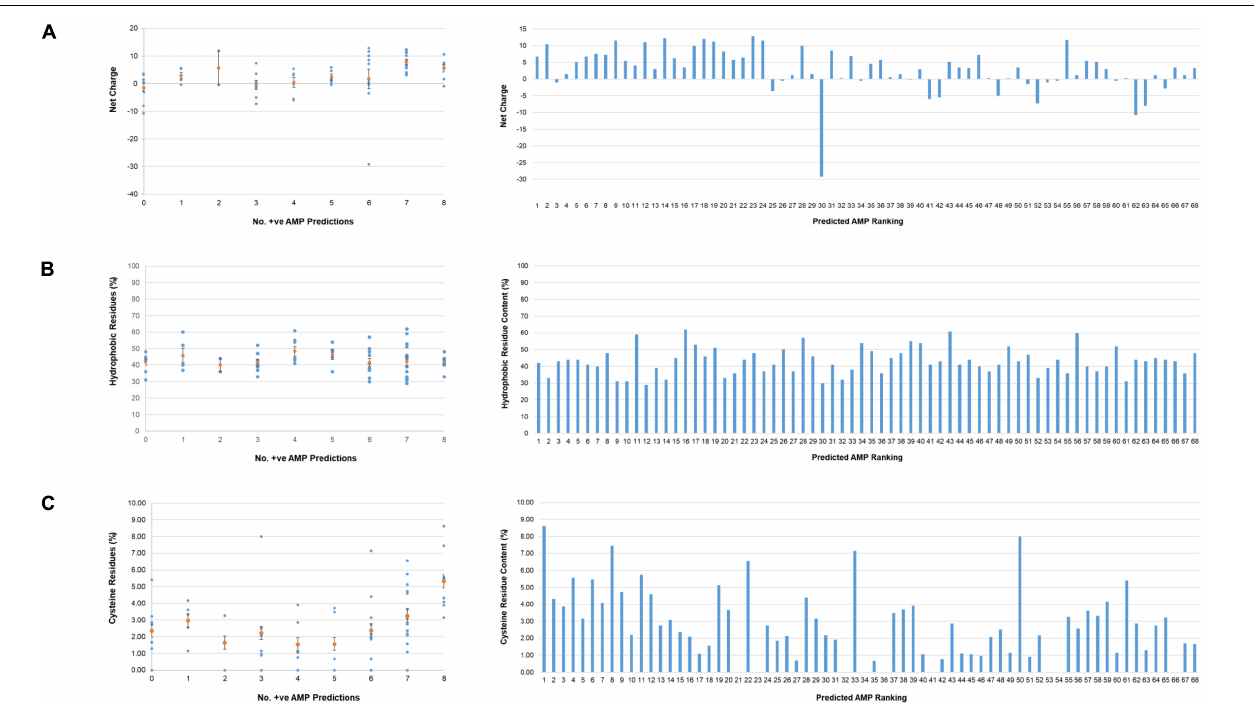
FIGURE 3 | Physicochemical properties of T. pallidum miniproteins of unknown function. Physicochemical properties known to be important for AMP function were calculated for the 68 T. pallidum proteins ( ≤ 150 amino acids) of unknown function using the APD3 online AMP calculator and predictor tool. Left: Scatter plots depicting (A) net charges, (B) hydrophobic residue content, and (C) cysteine residue content (orange circles represent the mean values, +/- standard error) of all proteins from each positive AMP prediction class. Right: Bar graphs showing (A) net charge, (B) hydrophobic amino acid content, and (C) cysteine residue content of all 68 miniproteins ( ≤ 150 amino acids) from predicted AMP ranking 1–68. No. +ve AMP Predictions equates to the number of AMP prediction programs that assigned the miniprotein as an